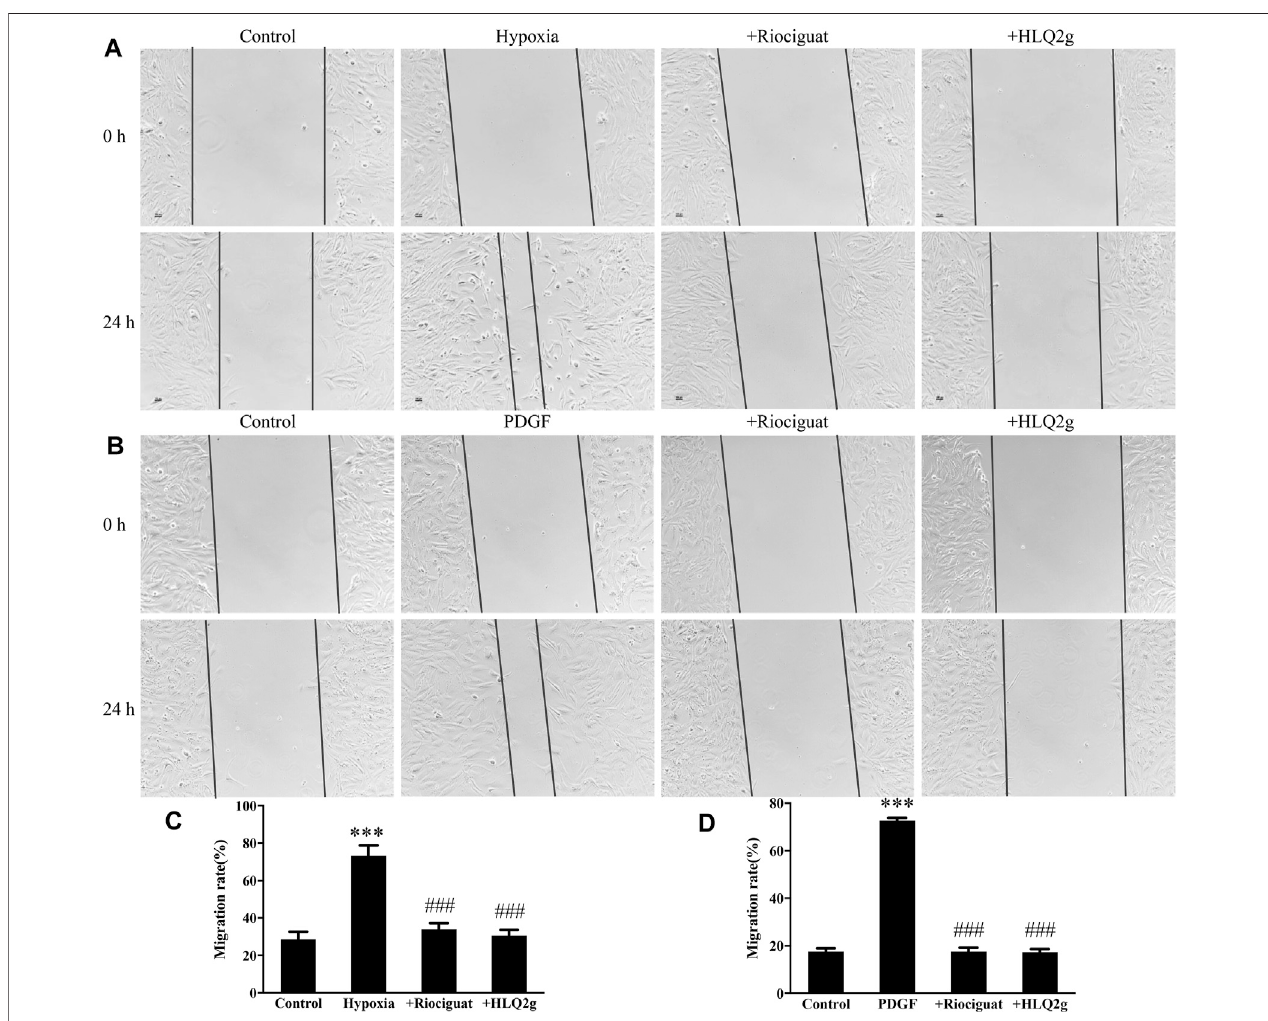
FIGURE5| HLQ2g caninhibit themigrationofHPASMCs. (A, B) :Scratchtestresults(100 μ m); (C) :StatisticalanalysisofA; (D) :StatisticalanalysisofB.Riociguat (1 μ M); HLQ2g (1 μ M). Data are expressed as mean ± SD, n (cid:1) 3. Vs. the control, *** p < 0.001; vs. the PDGF/Hypoxia group, ### p < 0.001.